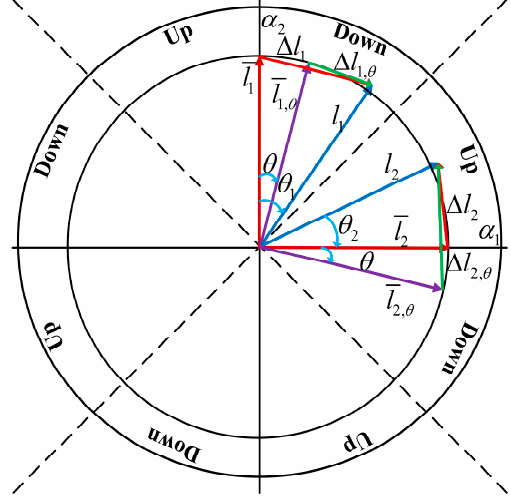
Figure 4. Schematic diagram of phase